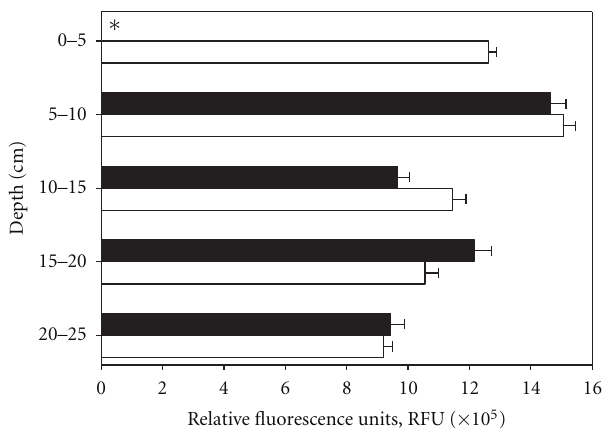
Figure 5: Depth profiles (0 to 25 cm) of bacterial spore content (expressed as equivalents of B. subtilis ) in soil from a pasture. Comparison between autoclaving (open bars) and microwaving (solid bars) in releasing dipicolinic acid (DPA). Bars represent mean values of triplicate samples. ∗ Sample was lost during filtration